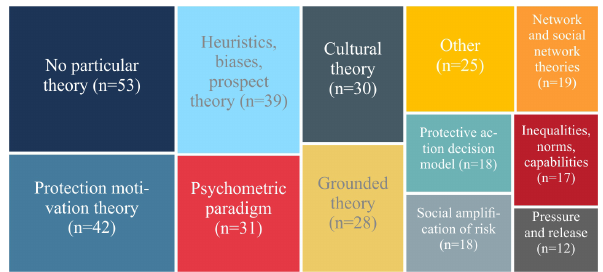
Figure 2. Replies to the question, “Did you ever use a theoretical model or framework to guide the design of any of your studies on risk perception or behaviour?” Only theories that were mentioned more than 10 times are